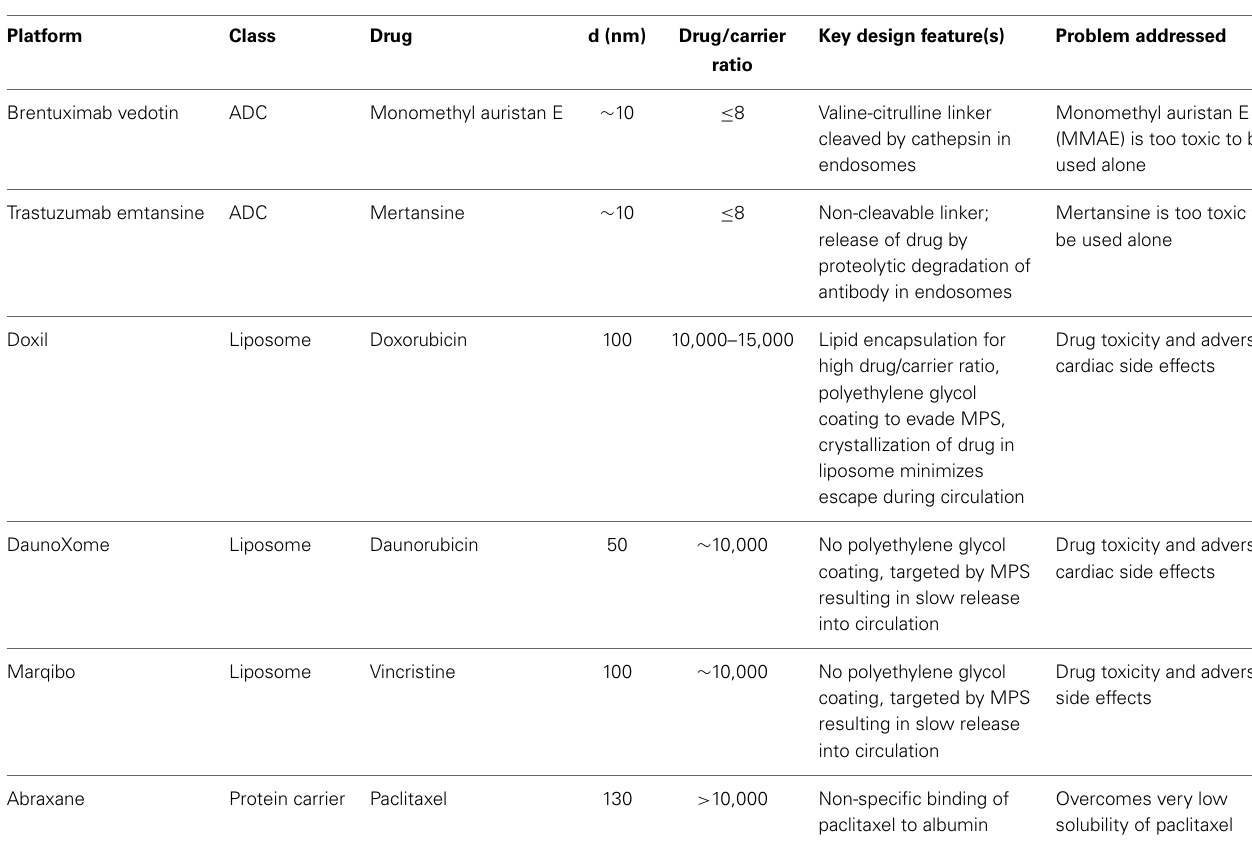
Table 1 | Summary of FDA-approved nanomedicines.